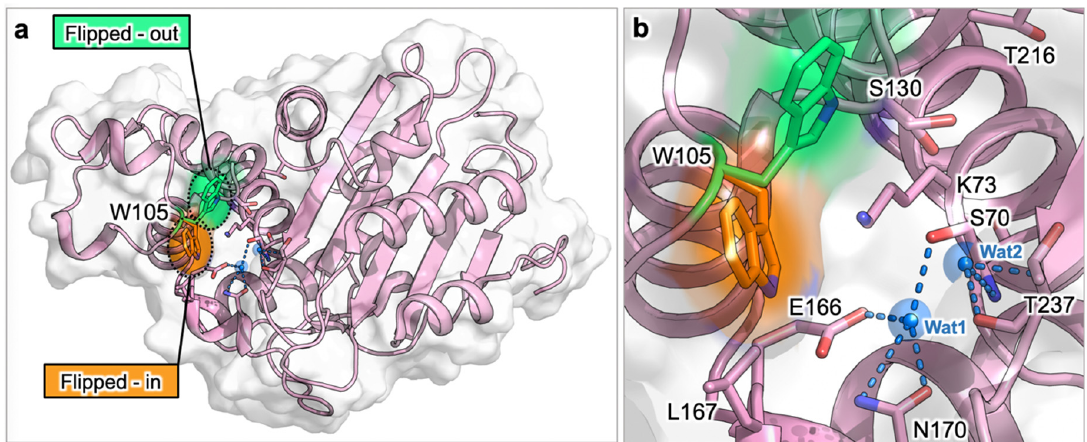
Figure 2. Flipped-in and flipped-out conformations of Trp105 in KPC-2 (PDB ID: 5ul8). ( a ) Overall view of KPC-2. ( b ) Close-up of KPC-2 active site. In the most stable conformation (green), Trp105 side chain is close to Thr216, while in the flipped-in conformation (orange), the indole ring approaches Leu167. Protein is represented in pink cartoon and gray surface, important active site residues are labelled and shown as sticks. Relevant waters are depicted as blue spheres, and labelled: the deacylation water (Wat1) is coordinated by Glu166 and Asn170, while Wat2 occupies the oxyanion hole created by backbone nitrogens of Ser70 and Thr237.